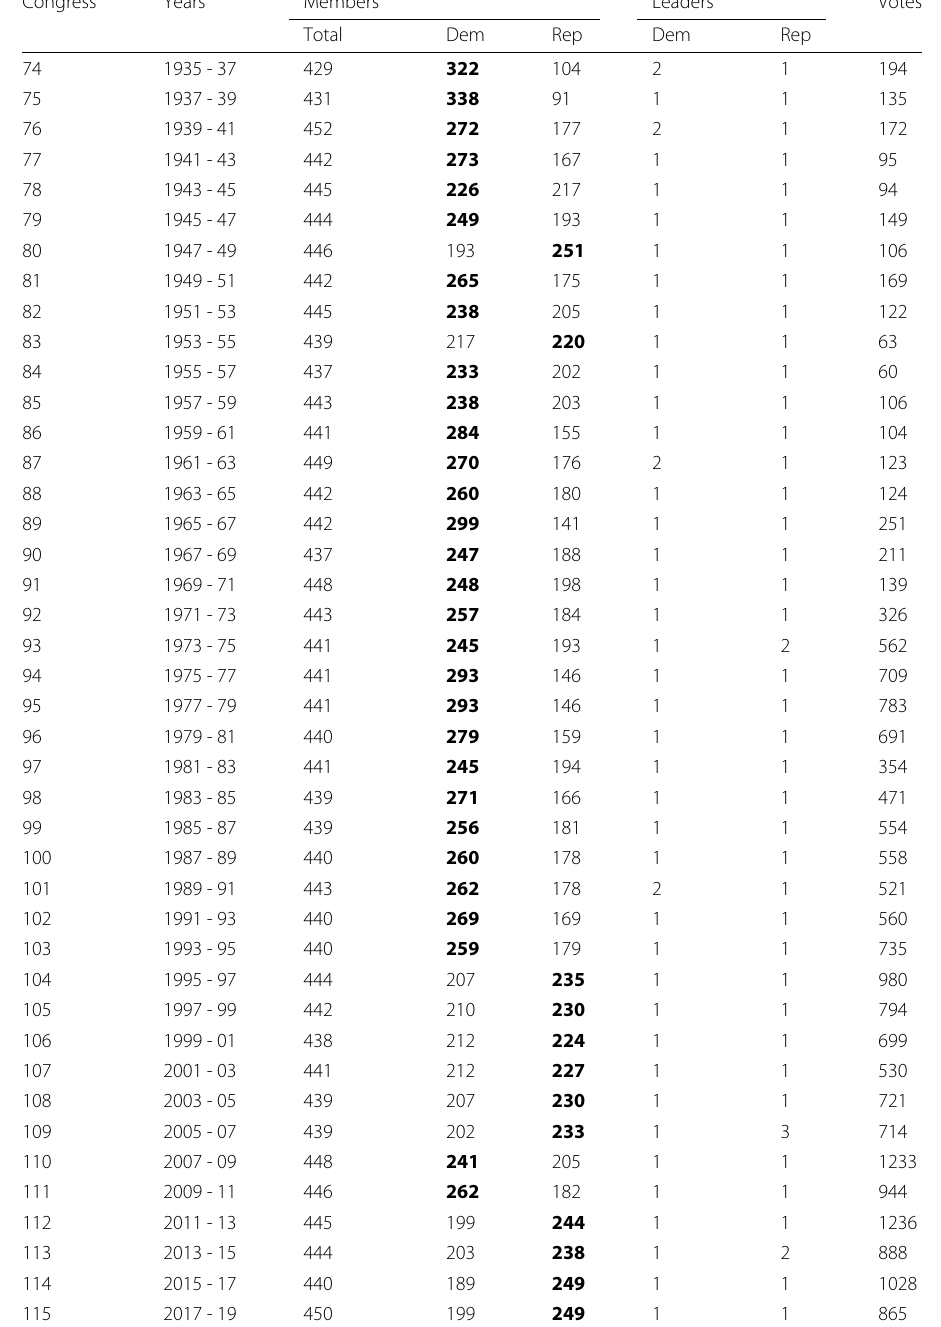
Table 1 Years covered, total number of members (nodes), number of Democrats (excluding leaders), number of Republicans (excluding leaders), number of Democrat leaders, number of Republican leaders, and number of roll call votes for each House